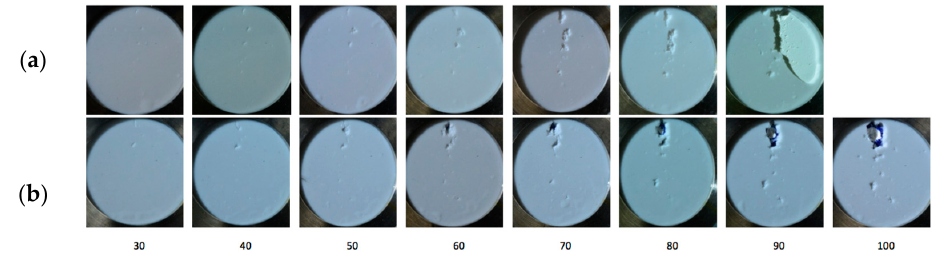
Figure 26. Images of surface and delamination damage after time interval (in minutes) of testing: